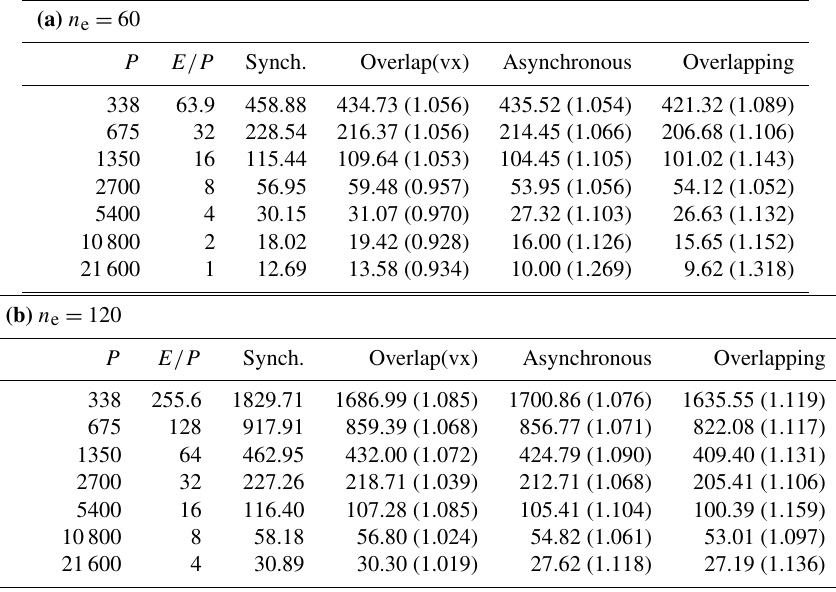
Table 2. Time in seconds for the synchronous, the overlapping with vertex connectivity, the asynchronous without vertex connectivity, and the overlapping without vertex connectivity communication methods for the DG (np = 6, nlev = 26) strong scaling for n e = 60 (a) and n e = 120 (b) . P denotes the number of cores used in the